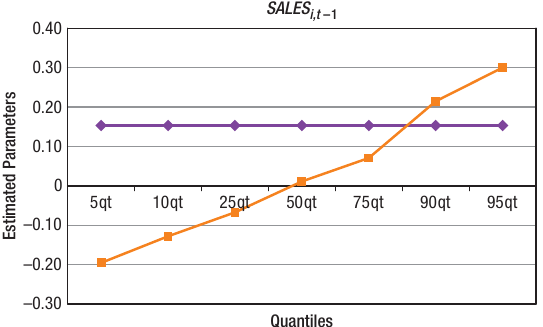
and SALES i , t i , t –1